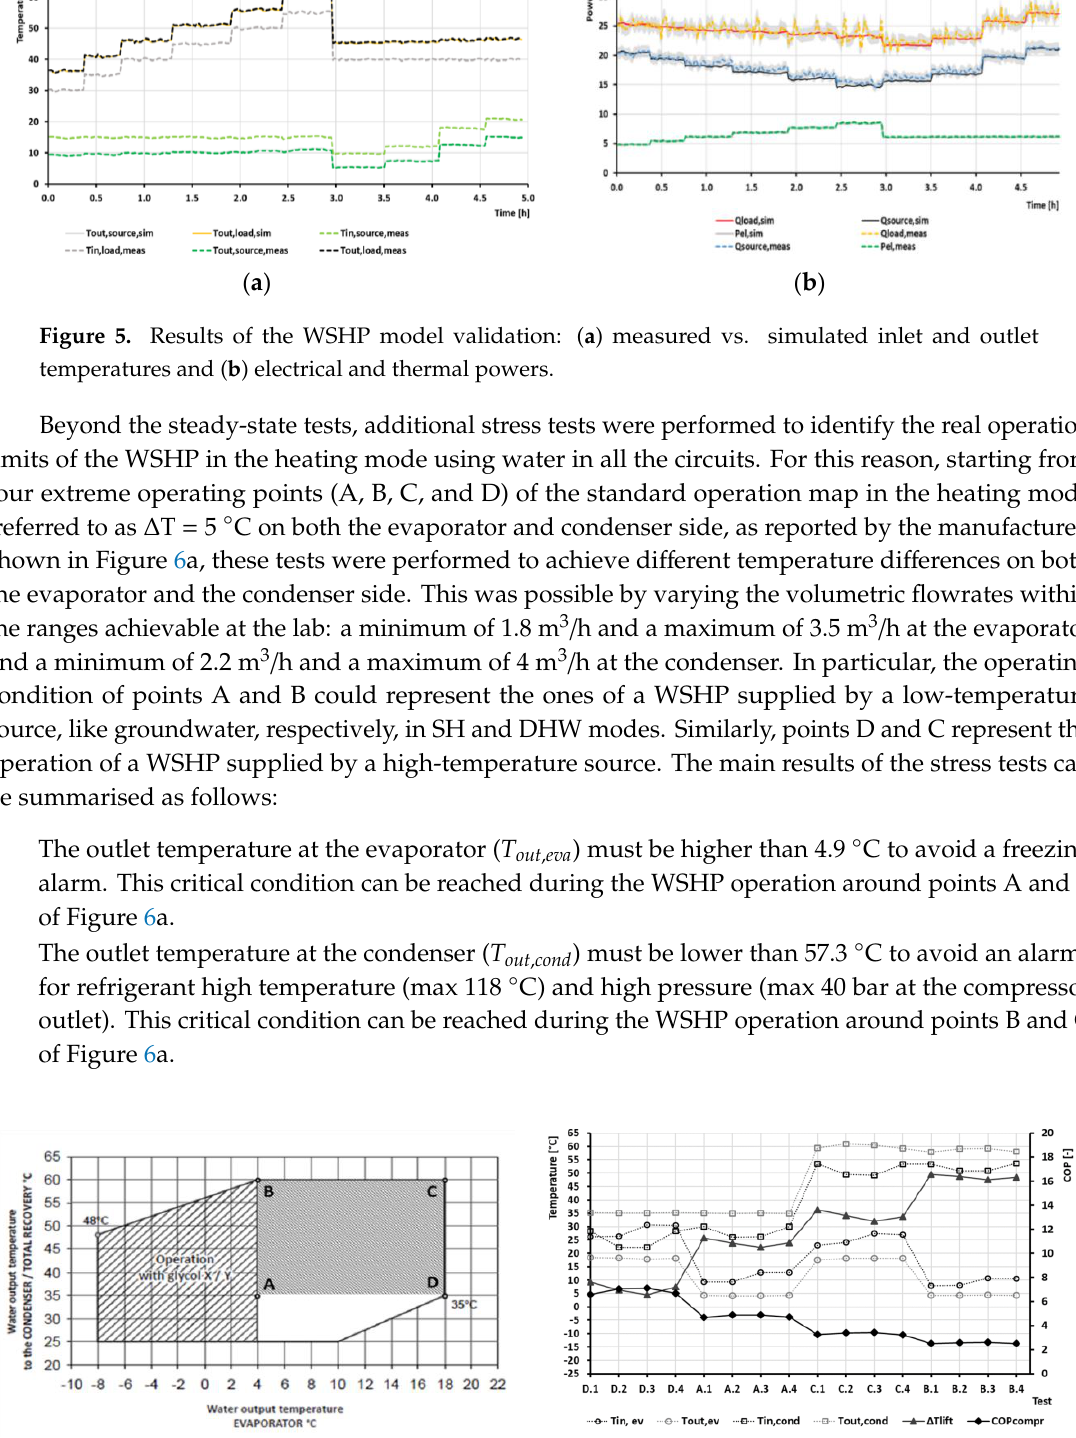
Figure 4. Results for the different variables considered for the water-source heat pump (WSHP) model calibration: ( a ) normalised mean bias error (NMBE) vs. coefficient of variation of the root mean square error ( CVRMSE) and ( b ) goodness of fit (GOF) NMBE vs. GOF CVRMSE.